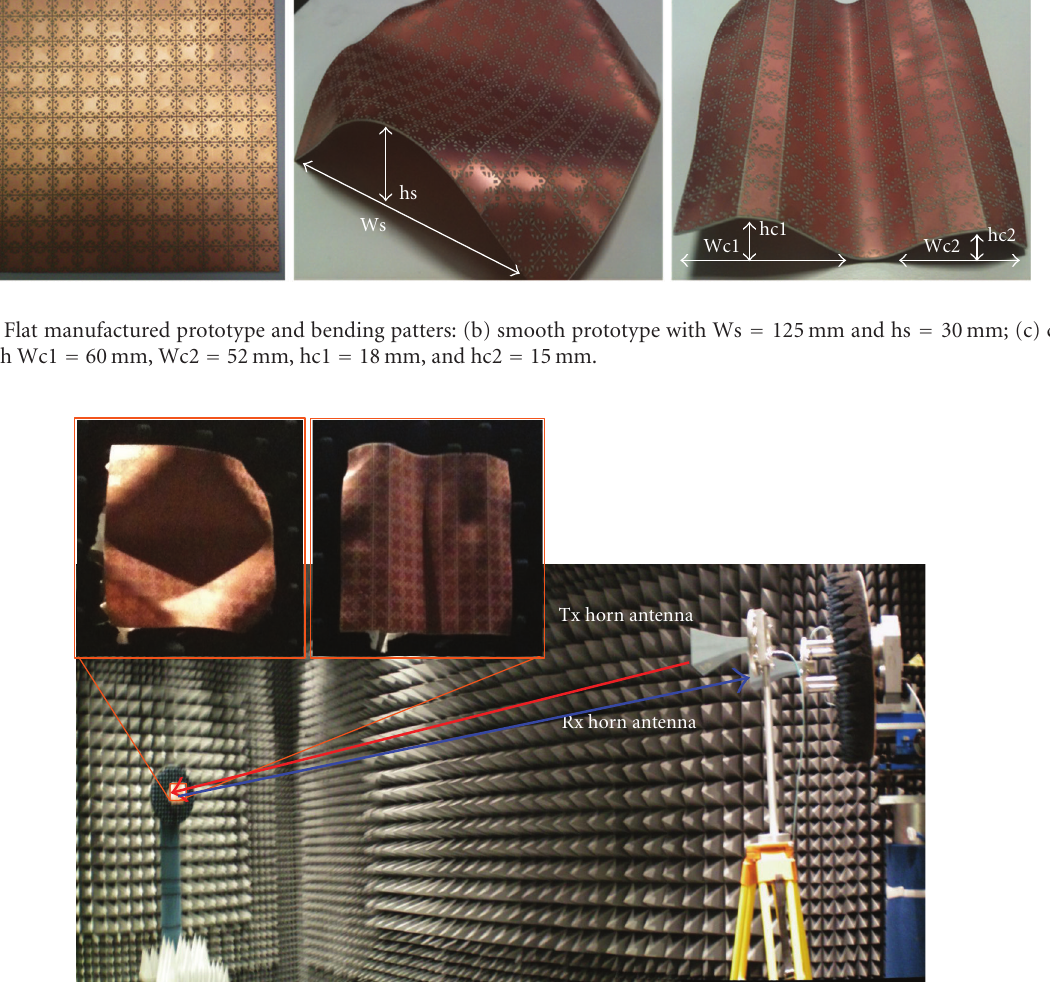
Figure 5: Reflection coe ffi cient measurement setup in anechoic chamber.